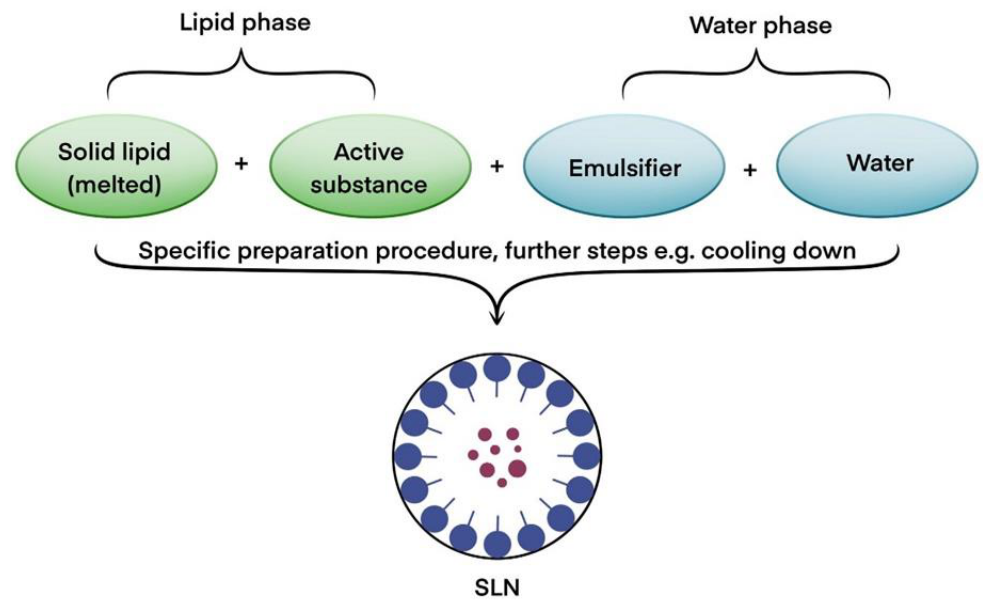
Figure 2. Block diagram of the solid structure of a lipid nanoparticle. Based on [20].